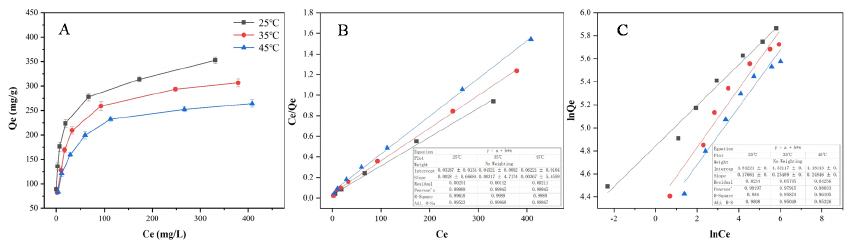
Figure 3. Adsorption isotherms of PMFs on CNPC1 at different temperatures ( A ) and the liner fitting of the Langmuir ( B ) and Freundlich thermodynamic models ( C ).